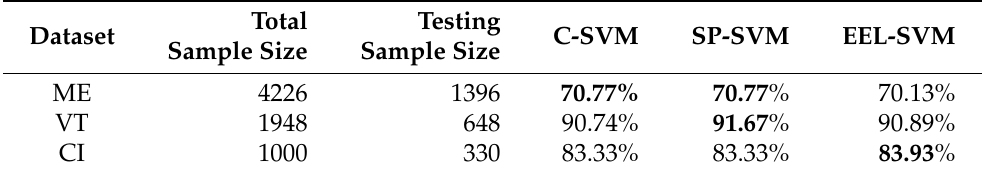
Table 7. Summaries of HMDA datasets and their accuracy levels. Highest accuracy along each row in